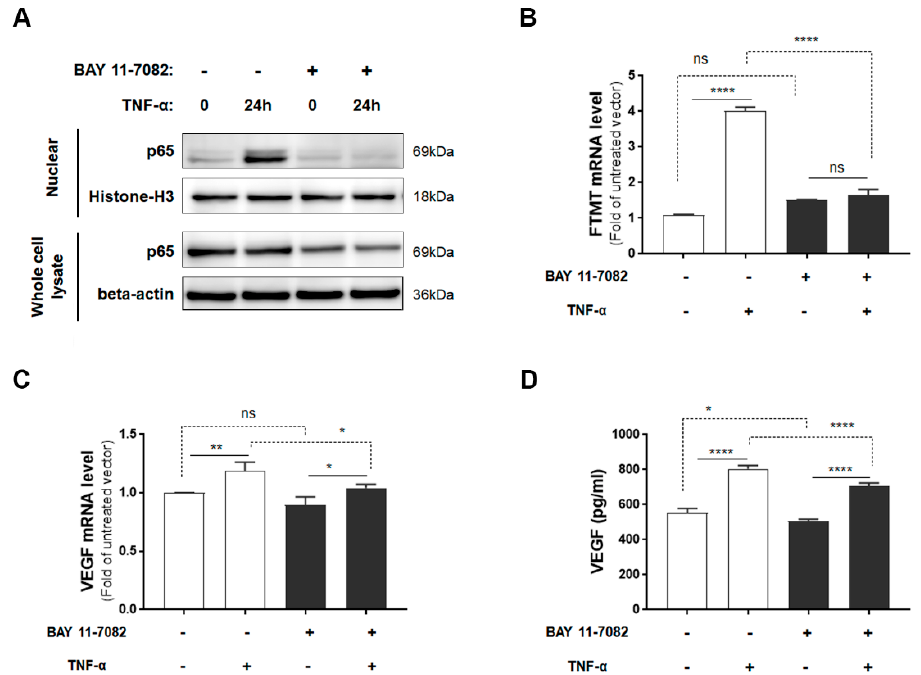
Figure 3. FTMT mRNA expression and VEGF protein secretion in response to TNF- α with or without NF- κ B inhibitor BAY 11-7082: ( A ) Translocated levels of NF- κ B subunit (p65) in nuclear extracts or in whole cell lysates after 24 h incubation with or without TNF- α (10 ng / mL) and BAY 11-7082 (5 µ M). Relative levels of mRNA of ( B ) FTMT and ( C ) VEGF measured by qPCR and normalized by the ACTB gene in cells treated as in A ( n = 4). ( D ) VEGF protein levels in conditioned media of cells after 24 h incubation with or without TNF- α (10 ng / mL) and BAY 11-7082 (5 µ M) ( n = 6). Data were analyzed by one-way ANOVA with the Sidak’s post hoc test (* p < 0.05; ** p < 0.01, and **** p < 0.0001). Results are shown as mean ± SEM.